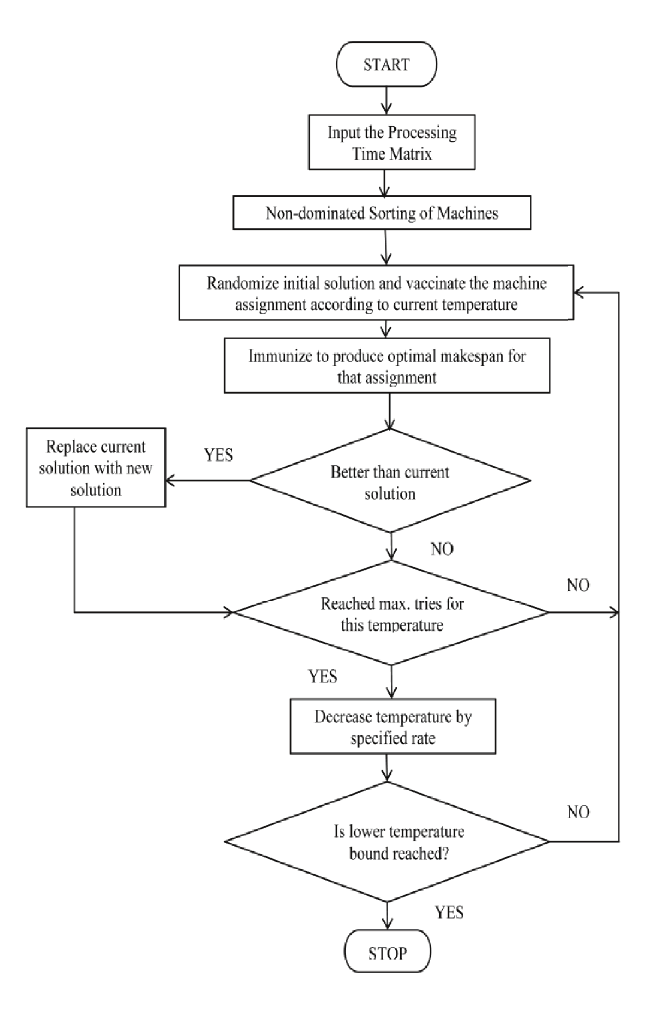
Fig. 3 Flow chart showing HSISA